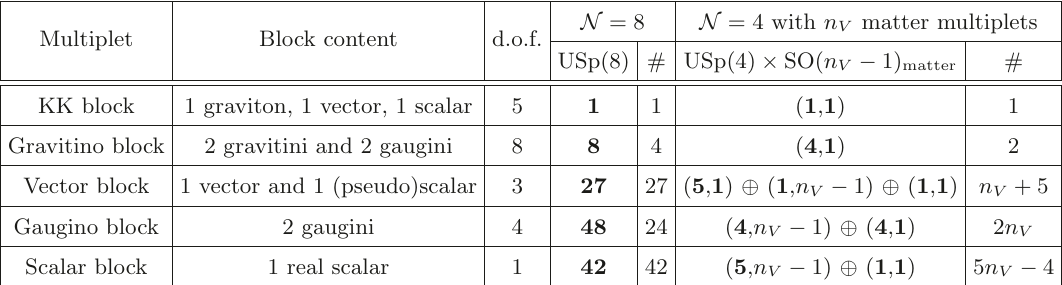
Table 1 . Decoupled quadratic fluctuations around the KK black hole in supergravity. The columns # denote the multiplicity of the